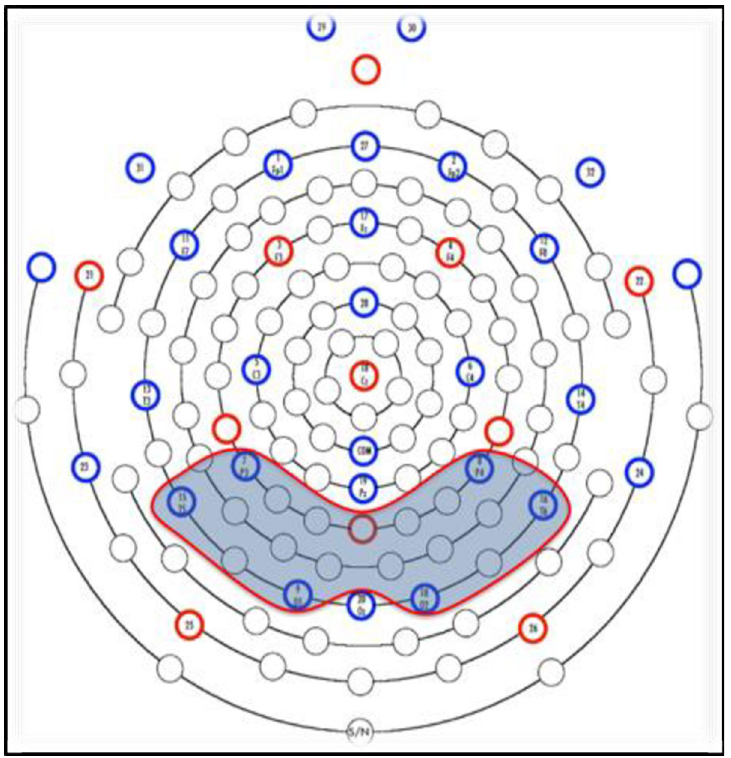
Fig 2. Sensor map for the EEG 32-sensor net. The region of interest is shaded in gray.